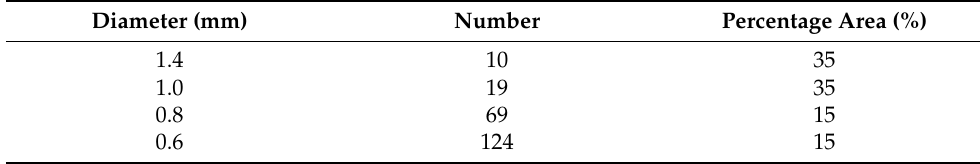
Table 1. Circle diameters and quantities.